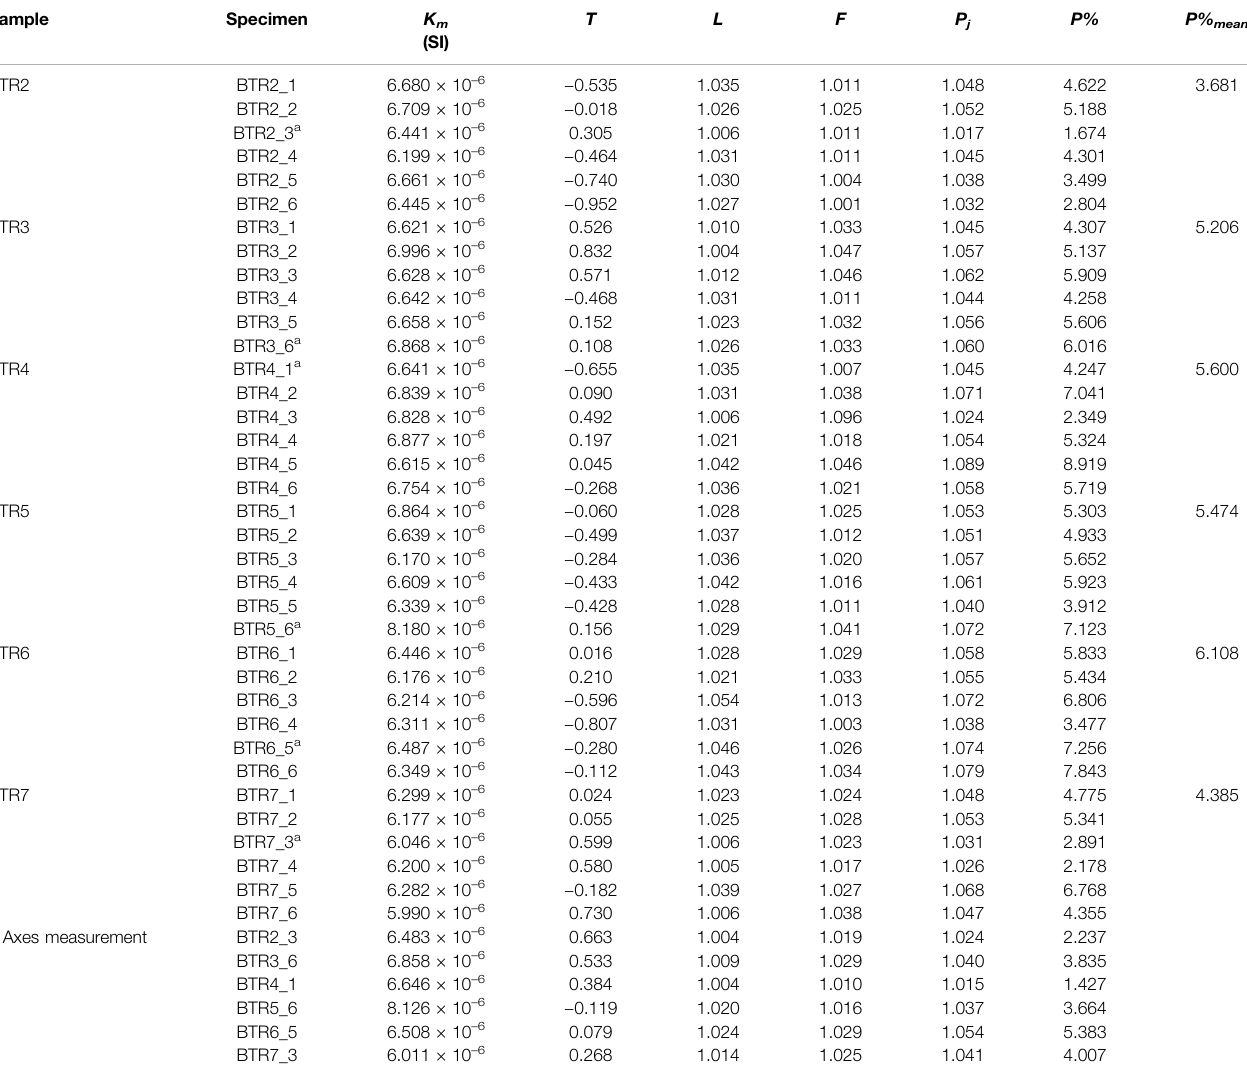
TABLE 1 | Magnetic anisotropy parameters for all specimens.